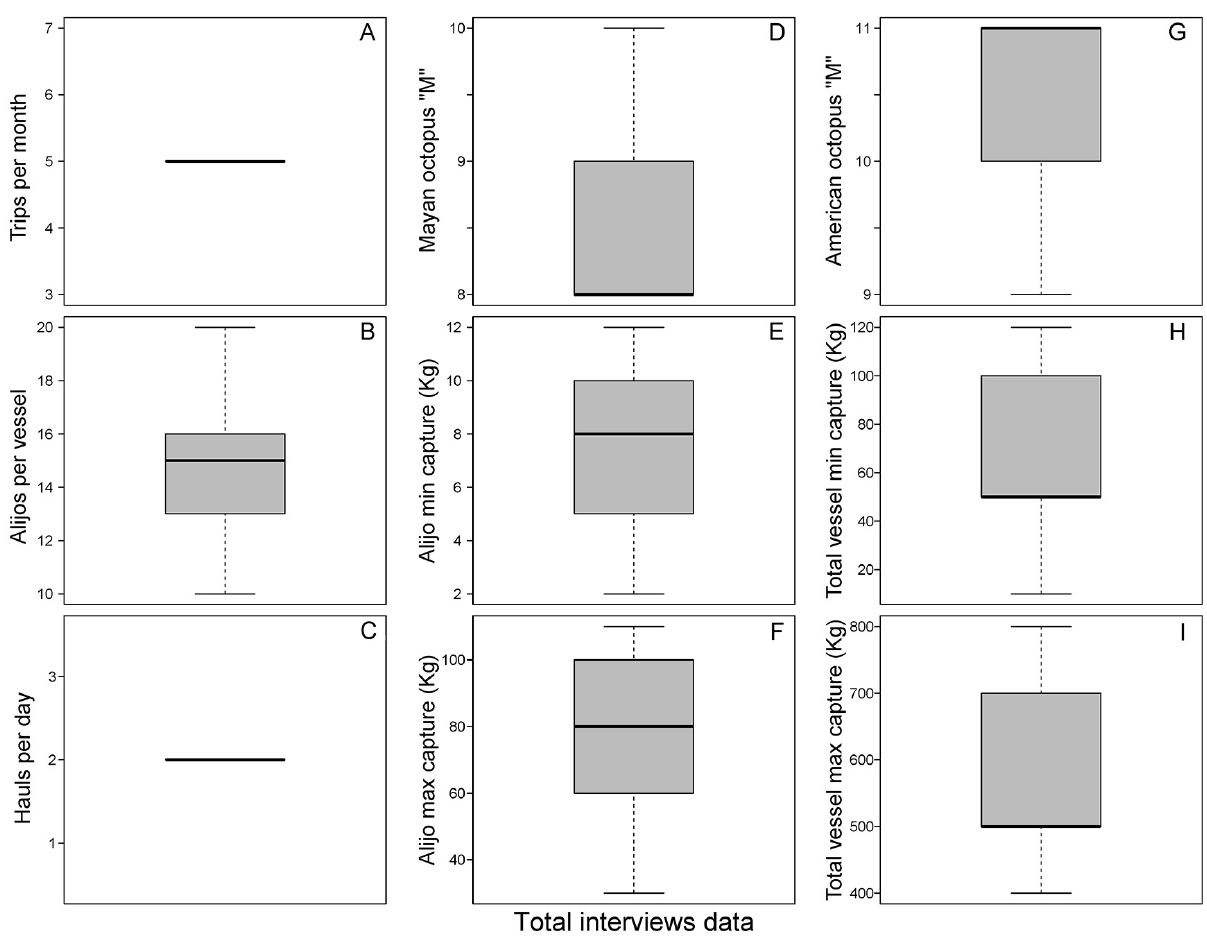
Fig. 5. – Distribution range from the parameters obtained from the total interviews with the skippers of the large-scale fleet targeting the O. maya and O. americanus in Yucatan, Mexico. A. Number of trips per month per mother vessel; B. Number of alijos per mother vessel; C. Number of hauls per day; D. O. maya “M”; E. Alijo minimum capture; F. Alijo maximum capture; G. O. americanus “M”; H. Total mother vessel minimum capture; I. Total mother vessel maximum capture. “M” means the month of maximum catch (peak of the